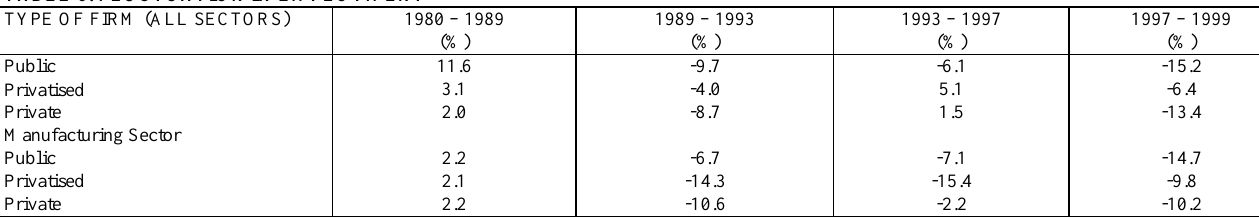
TABLE 6: FLUCTUATION IN EMPLOYMENT TYPE OF FIRM (ALL SECTORS)